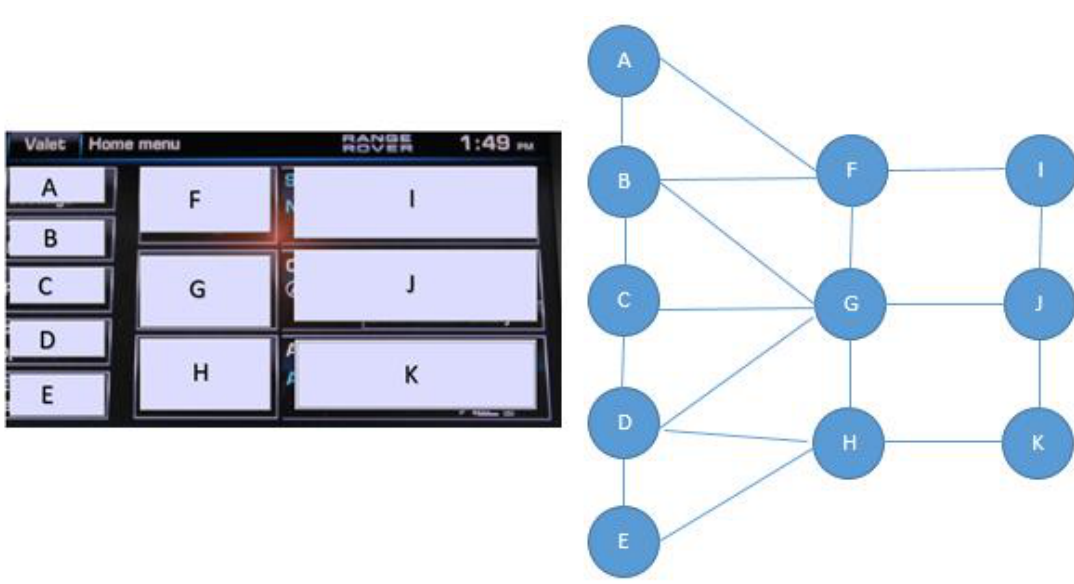
Figure 8. Graph structure of an interface.